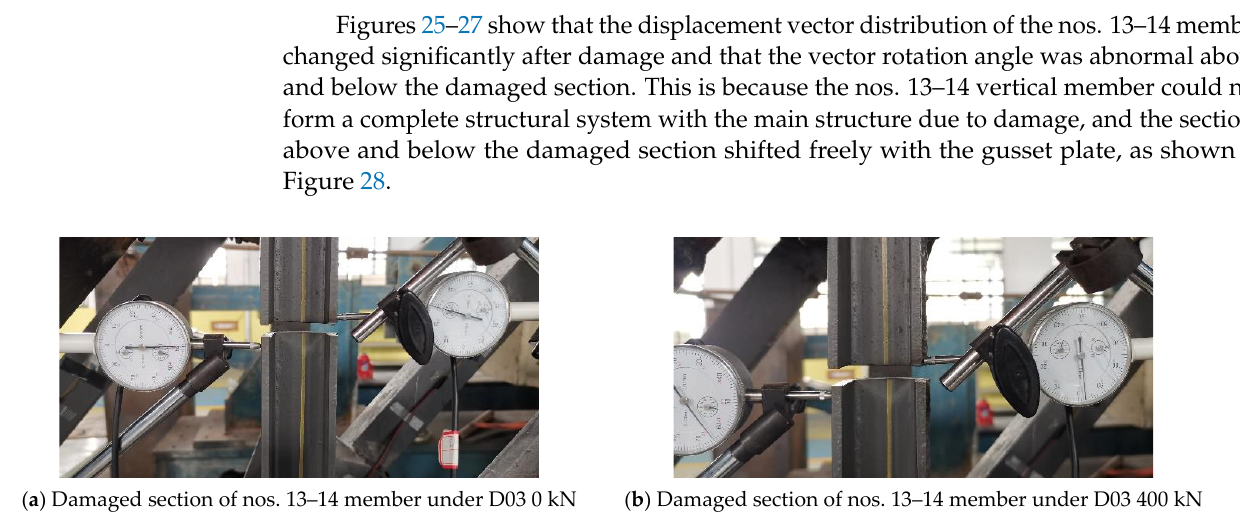
Figure 28. Relative displacement of nos. 13 – 14 damaged member under load condition D03.